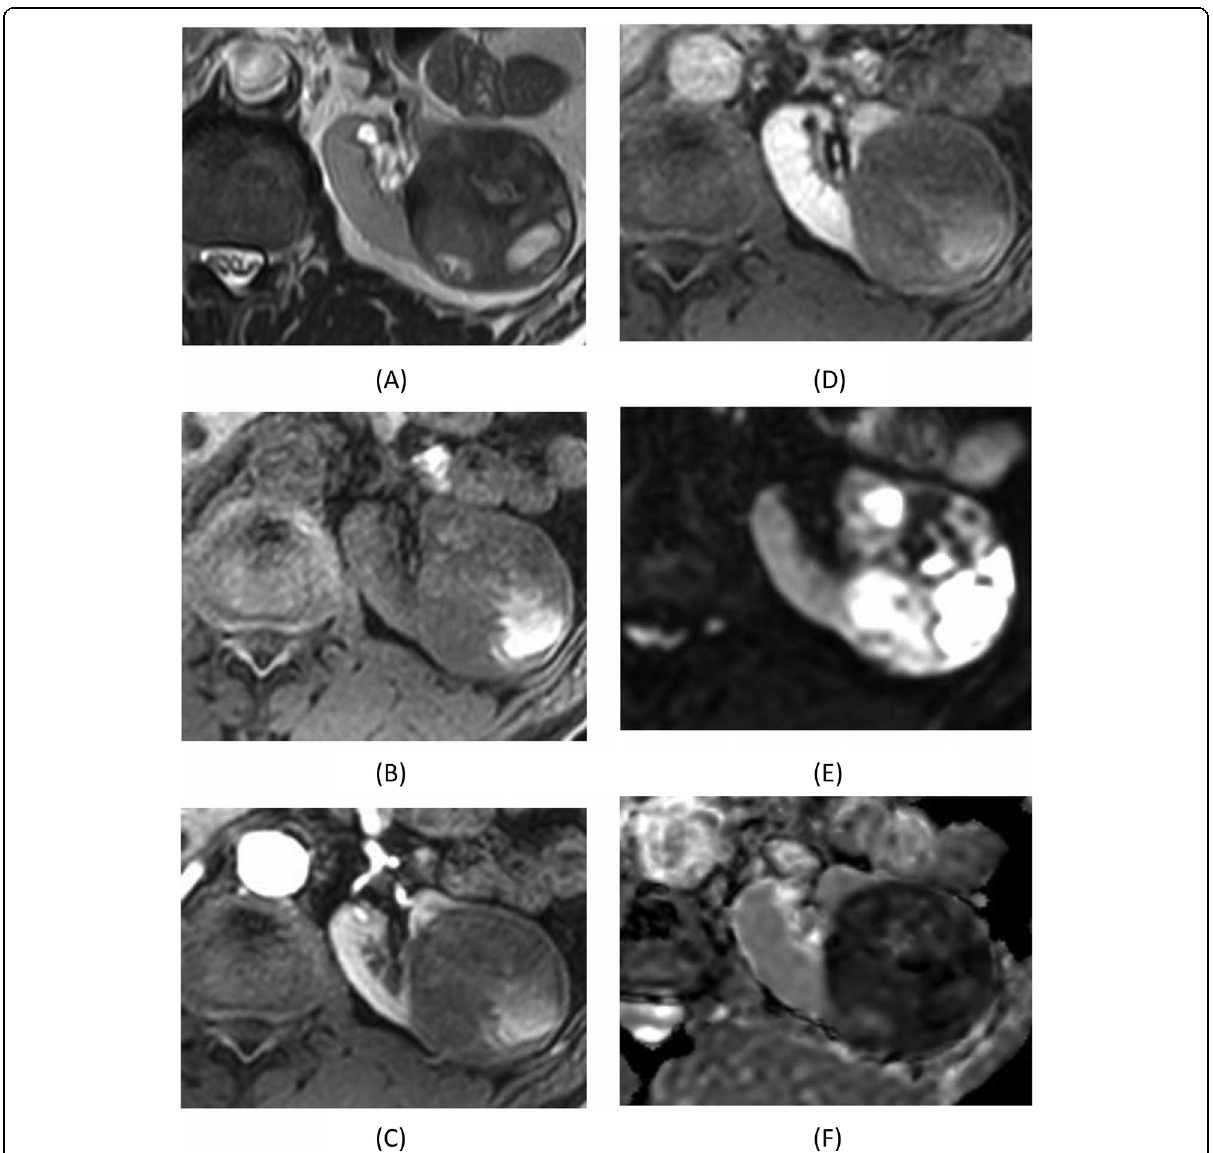
Fig. 7 Multiparametric MRI of p-RCC. A case of p-RCC in the left kidney of a 63-year-old male. a Axial T2-W fast SE MR image shows the pronounced renal mass low SI compared with renal parenchyma with areas of high SI at T1-W and T2-W images indicating hemorrhagic component. Axial non-enhanced ( b ) and gadolinium-enhanced T1-W FS GRE-MR images in corticomedullary ( c ) and nephrographic ( d ) show slow and progressive enhancement of the mass with non-enhancing hemorrhagic component. Axial DWI (b800mm 2 /s) ( e ) and ADC maps ( f ) show marked restriction of diffusion in the renal mass with ADC value (0.9 × 10 − 3 mm 2